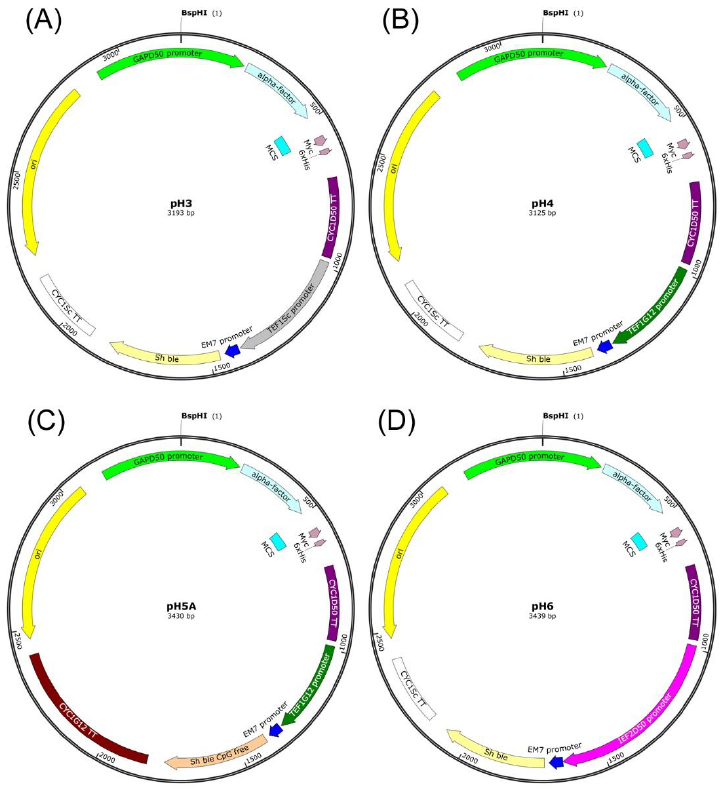
Figure 4. Maps of shuttle expression/integration vectors pH3, pH4, pH5A, and pH6 used in this study. All vectors contain the following elements: the pUC origin of replication (ori) for maintenance of plasmids in E. coli , the expression cassette consisting of D. macquariensis D50-derived GAP pro- moter (GAPD50 promoter), the sequence encoding S. cerevisiae - derived α -mating factor signal pep- tide (alpha-factor), multiple cloning site (MCS), C-terminal myc epitope (Myc), C-terminal polyhis- tidine tag (6xHis), and the D. macquariensis D50-derived CYC1 transcription termination region (CYC1D50 TT). The pH3 vector ( A ) also contains the selection marker expression cassette composed of S. cerevisiae -derived TEF1 promoter (TEF1Sc promoter), synthetic prokaryotic promoter that drives expression of the Sh ble gene in E. coli (EM7 promoter), S. hindustanus -derived ble gene con- ferring resistance to Zeocin (Sh ble), and the S. cerevisiae -derived CYC1 transcription termination region (CYC1Sc TT). The pH4 vector ( B ) contains the selection marker expression cassette composed of C. santamariae G12-derived TEF1 promoter (TEF1G12 promoter), synthetic prokaryotic EM7 pro- moter, Sh ble gene conferring resistance to Zeocin, and the S. cerevisiae -derived CYC1 transcription termination region (CYC1Sc TT). The pH5A vector ( C ) contains the selection marker expression cas- sette, composed of C. santamariae G12-derived TEF1 promoter (TEF1G12 promoter), synthetic pro- karyotic EM7 promoter, the modified Sh ble gene (Sh ble CpG free), and the C. santamariae G12- derived CYC1 transcription termination region (CYC1G12 TT). The pH6 vector ( D ) contains the se- lection marker expression cassette composed of D. macquariensis D50-derived IEF2 promoter (IEF2D50 promoter), the EM7 promoter, the Sh ble gene, and the S. cerevisiae -derived CYC1 tran- scription termination region (CYC1Sc TT).